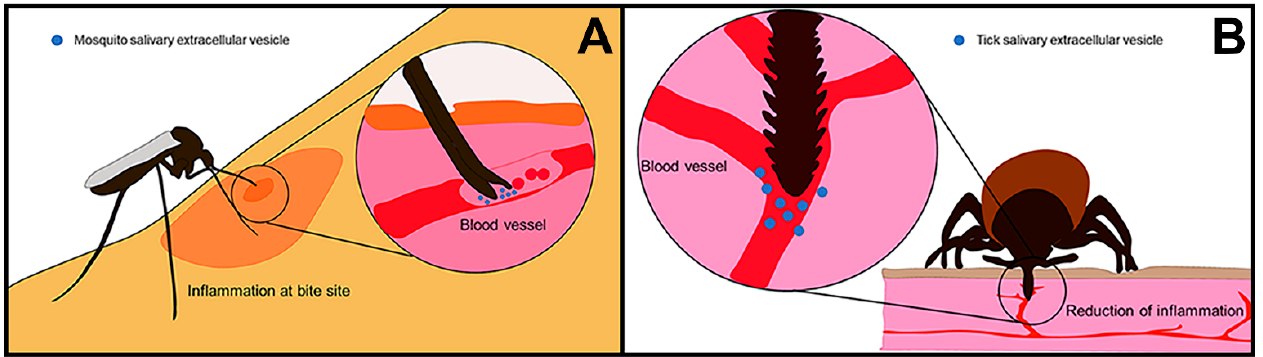
Figure 1. Extracellular vesicle secretion during arthropod feeding on vertebrate host. ( A ) Mosquitoes pierce the skin of their host using modified mouthparts. Their labella, labrum,